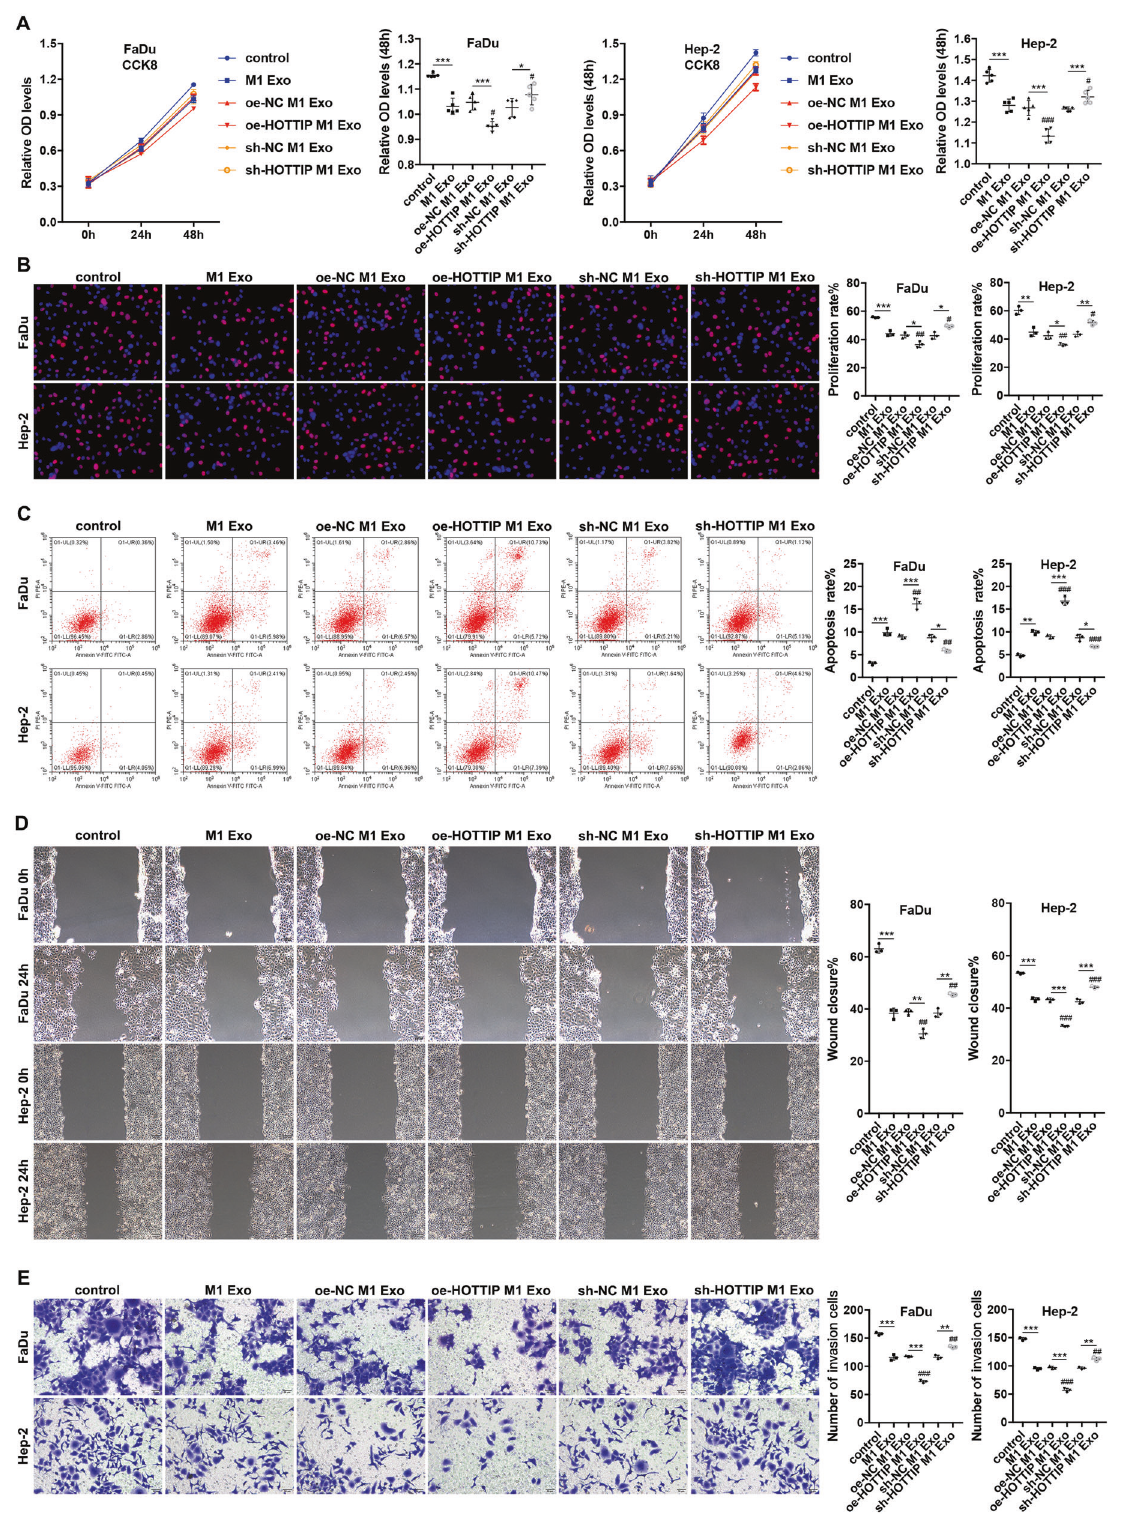
HOTTIP-knockdown Hep-2 cells were established, respectively (Fig. 3C, D). Here, the CCK-8 and EdU assays indicated that HOTTIP overexpression inhibited cancer cell proliferation, though HOTTIP knockdown induced proliferation (Fig. 3E, F). Flow cytometry analysis showed that HOTTIP overexpression triggered the